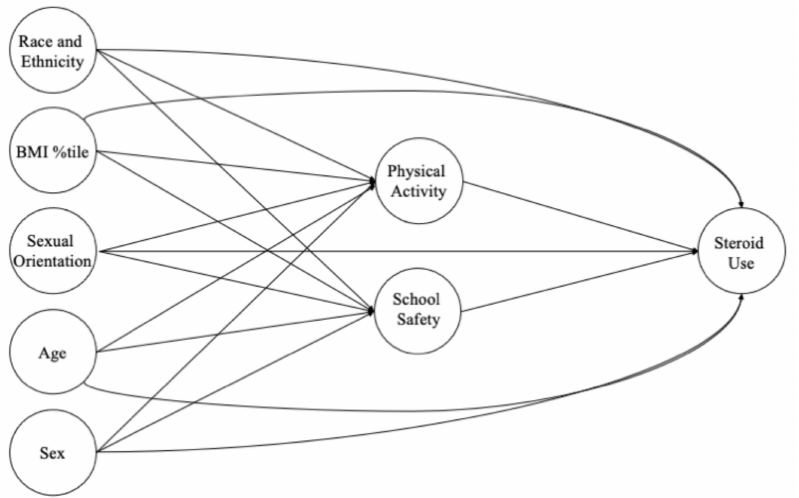
Figure 2. A directed acyclic graph (DAG) showing the theoretical and directional interrelationships among the study’s